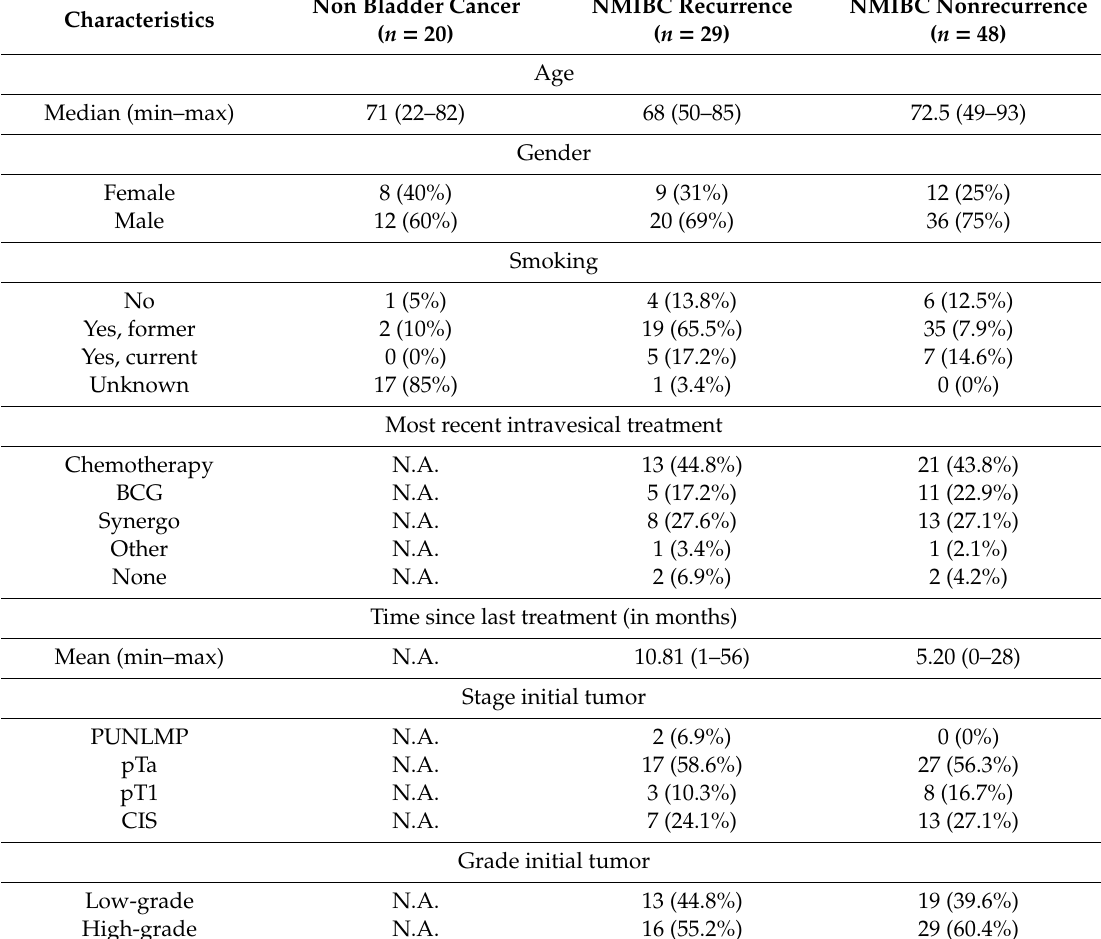
Table 1. Clinicopathological information on all enrolled study subjects ( n =